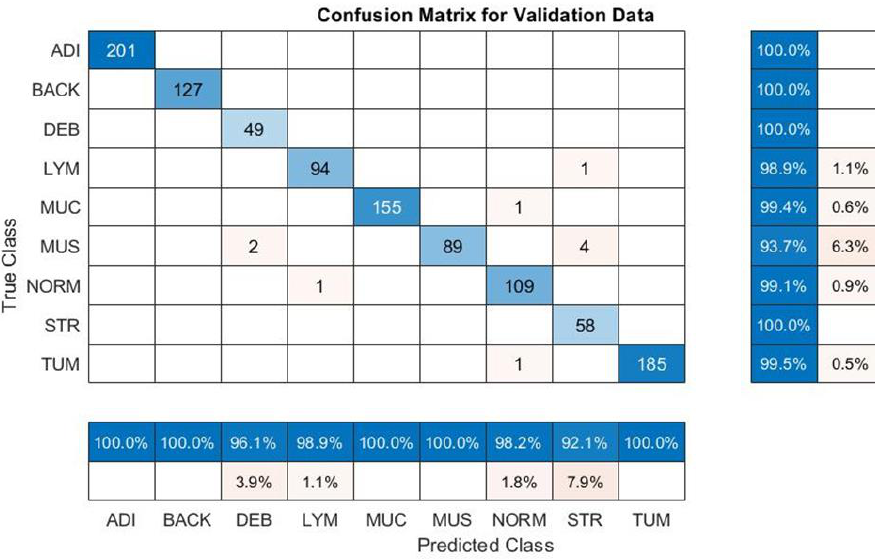
Bold symbols represent the maximum values of each row in the table.